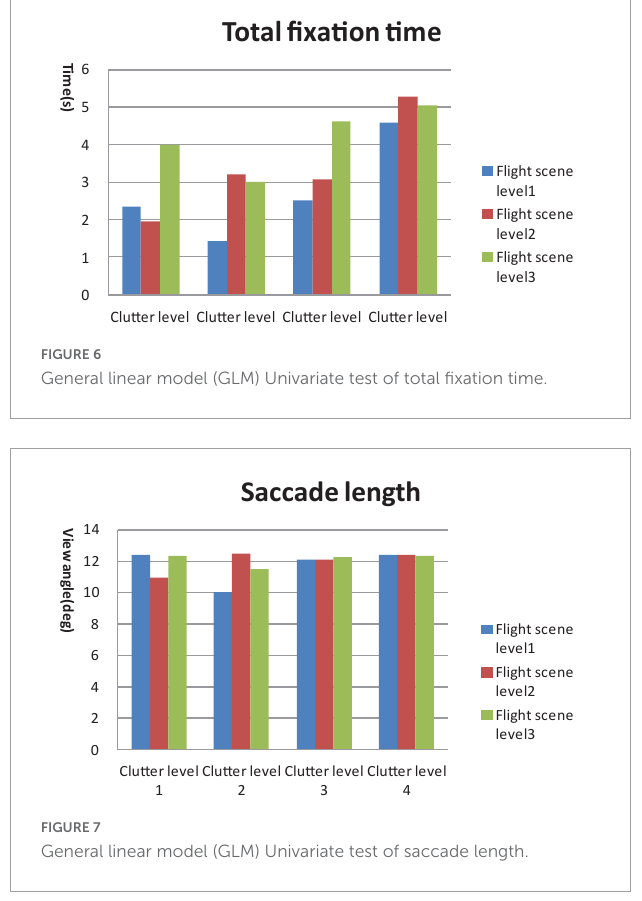
TABLE 2 Estimated marginal mean of Fixation time in (AOI) (s).